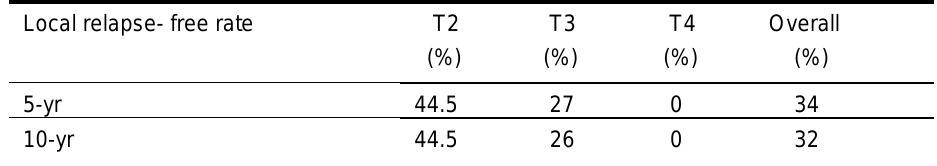
Local relapse-free rates for patients with T 2-T4 disease following radiation therapy. Local relapse- free rate